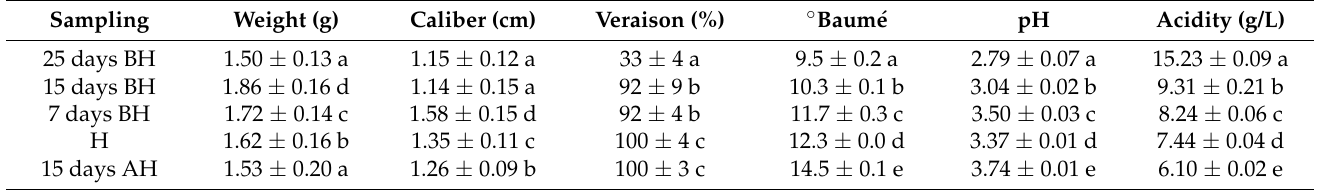
Table 2. General physical and chemical parameters of the Syrah grape sampling 1 .